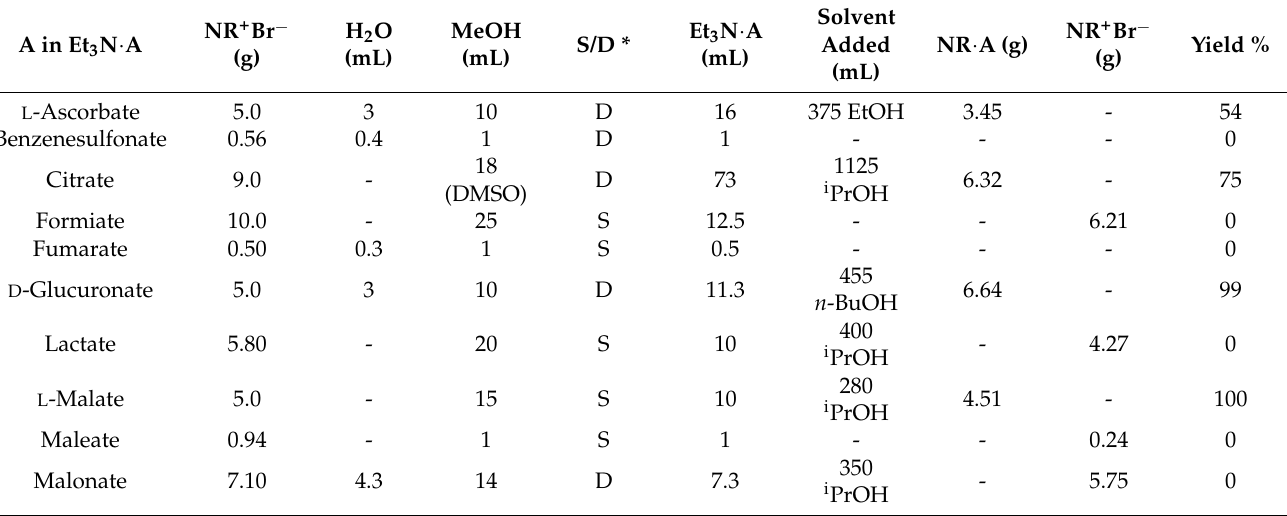
Table 1. Salt metathesis results with NR + neutral